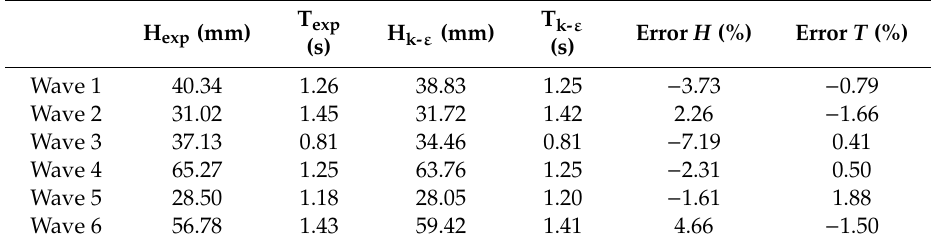
Table 6. Comparison of the wave height and period of the resultant wave between the experimental and k- ε model, and the error between